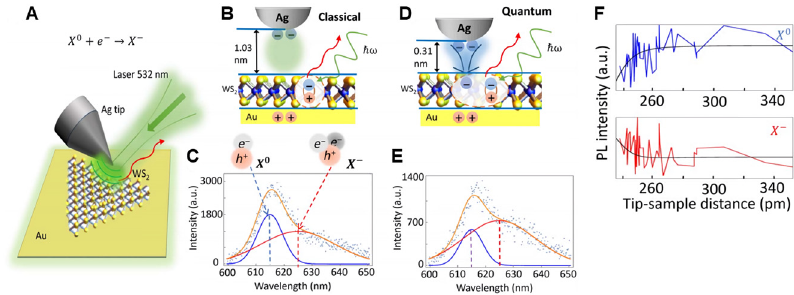
Figure 15: (A) Evolution of TEPL spectra of a WSe 2 monolayer under the tip-force regulation exhibiting irreversible PL energy shift (top). Far- fi eld PL spectra of as-grown and transferred WSe 2 monolayer on the SiO 2 substrate (bottom). (B) Evolution of TEPL spectra of a WSe 2 monolayer under weaker tip interaction exhibiting reversible PL energy shift. Reprinted with permission from [20]. Copyright (2016) American Chemical Society. onto the local spot and retracting the tip from the crystal, the tensile strain could be released at the nano-scale. They could monitor the changed strain by measuring TEPL spectra simultaneously. Figure 15A shows an irreversible strain shift with respect to the increased compressive force by the tip regulation. The induced tensile strain on the crystal was estimated from the peak shift of simultaneously measured TEPL spectra. The maximum 48 meV of PL peak shift was observed through the nano-mechanical tip-force regulation. Note that PL quantum yield of TMD crystal is decreased under strain due to the modi fi ed electronic band structure [147]. Furthermore, with the weaker tip-force control, tensile strain of the crystal and corresponding TEPL enegry could be reversibly controlled, as shown in